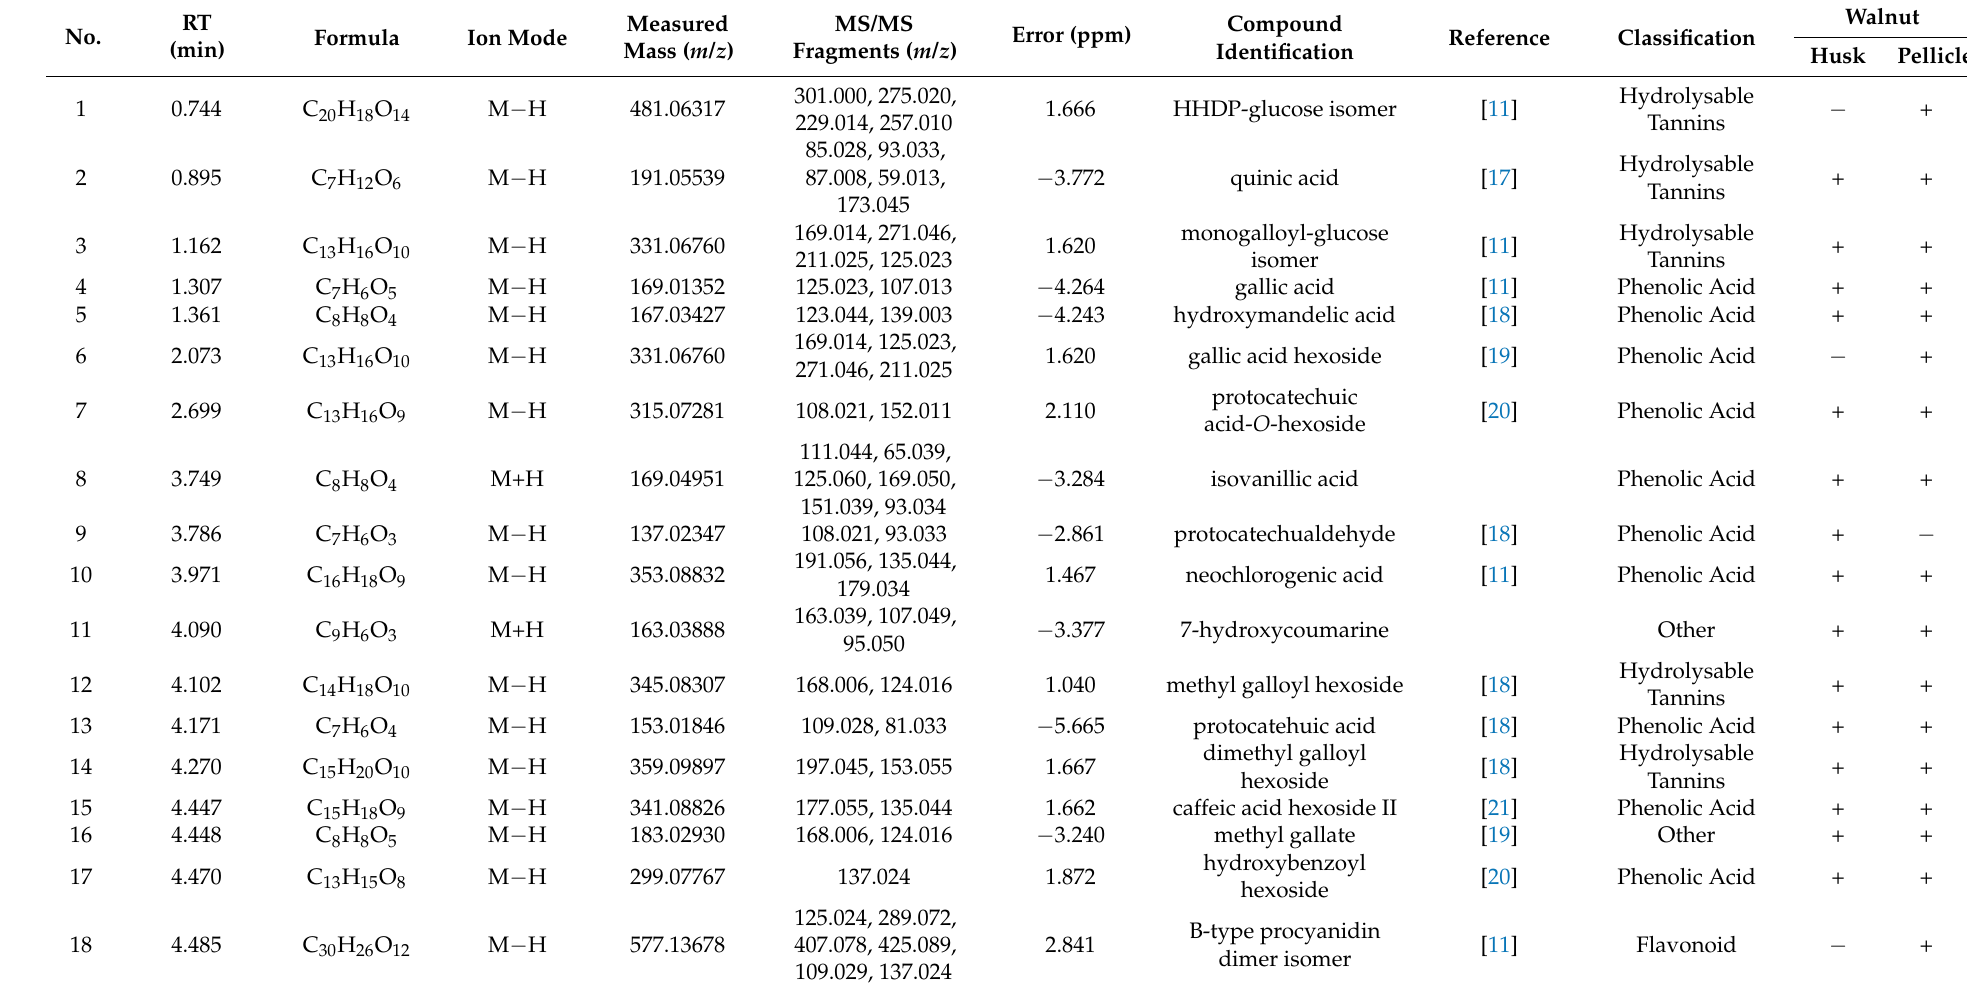
Table 1. Characterization of the components from walnut extracts by UHPLC–Q-Orbitrap